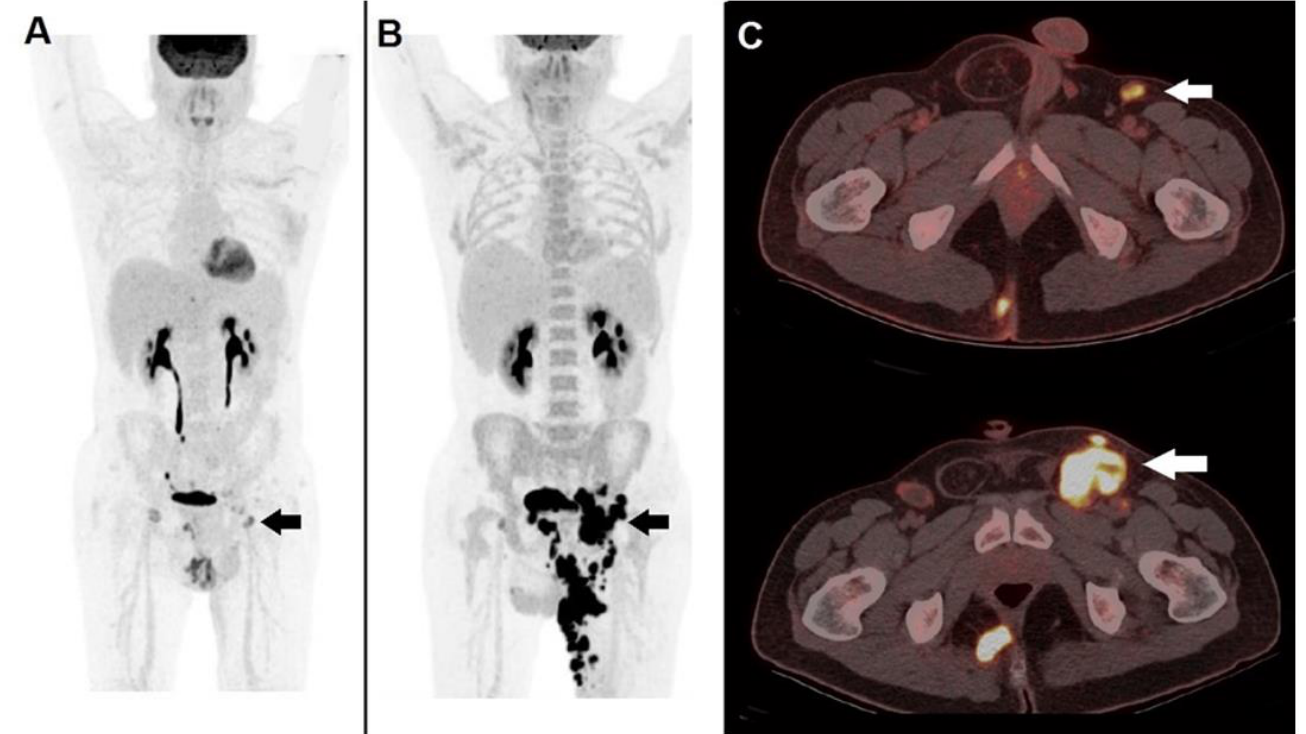
Figure 3. A case of hyper-progression during immunotherapy. A 41-year-old male, affected by non-melanoma skin cancer (locally advanced cutaneous squamous cell carcinoma) of the left thigh, submitted to anti PD-1 immunotherapy (cemiplimab). 18 F-FDG PET/CT before the start of therapy: